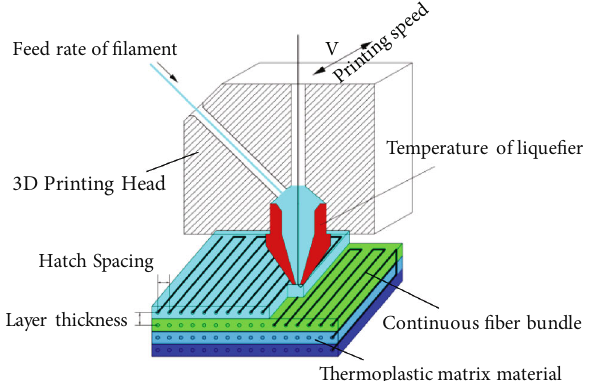
Figure 2: Scheme of 3D printing for the continuous fi ber reinforced thermoplastic